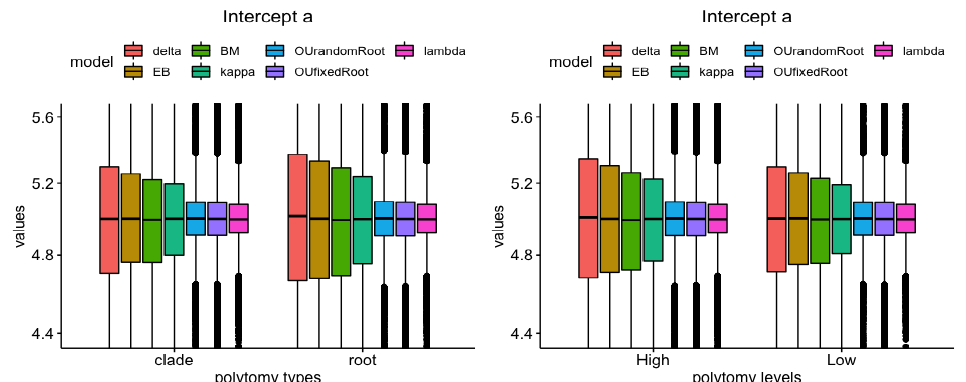
Figure 15. Regression intercept estimation concerning different models and polytomy types. Left panel : polynomial type vs. models. Right panel : polynomial level vs. models.